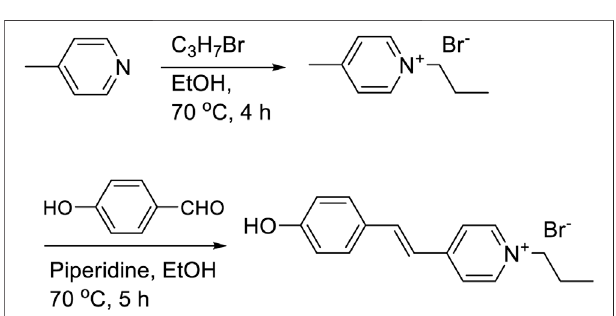
SCHEME 2 | Synthetic protocol of merocyanine dye (MCH +